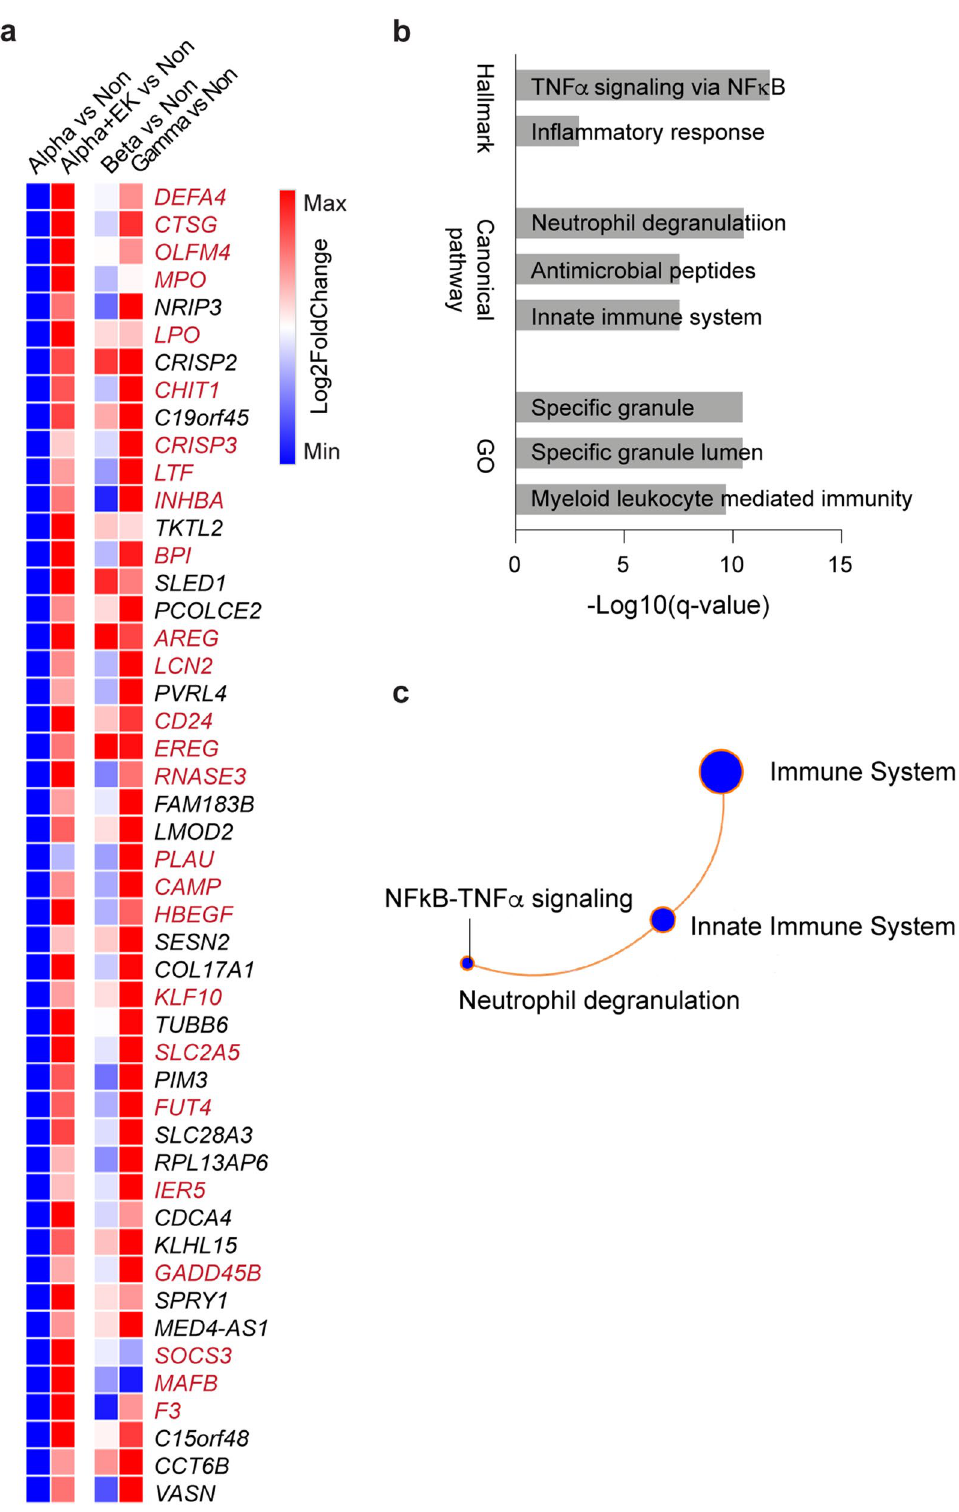
Figure 4. Distinct immune transcriptome signature in COVID-19 patients infected by different SARS-CoV-2 variants carrying the E484K mutation. ( a ) Heatmap shows the expression levels of 48 genes significantly induced by variants with the E484K mutation as compared to Non-COVID controls. Immune-related genes are in red. ( b , c ) GSEA analysis for Hallmark, Canonical pathway and Gene ontology (GO) of the 48 genes shows the enrichment of neutrophil degranulation via NFκB-TNFα